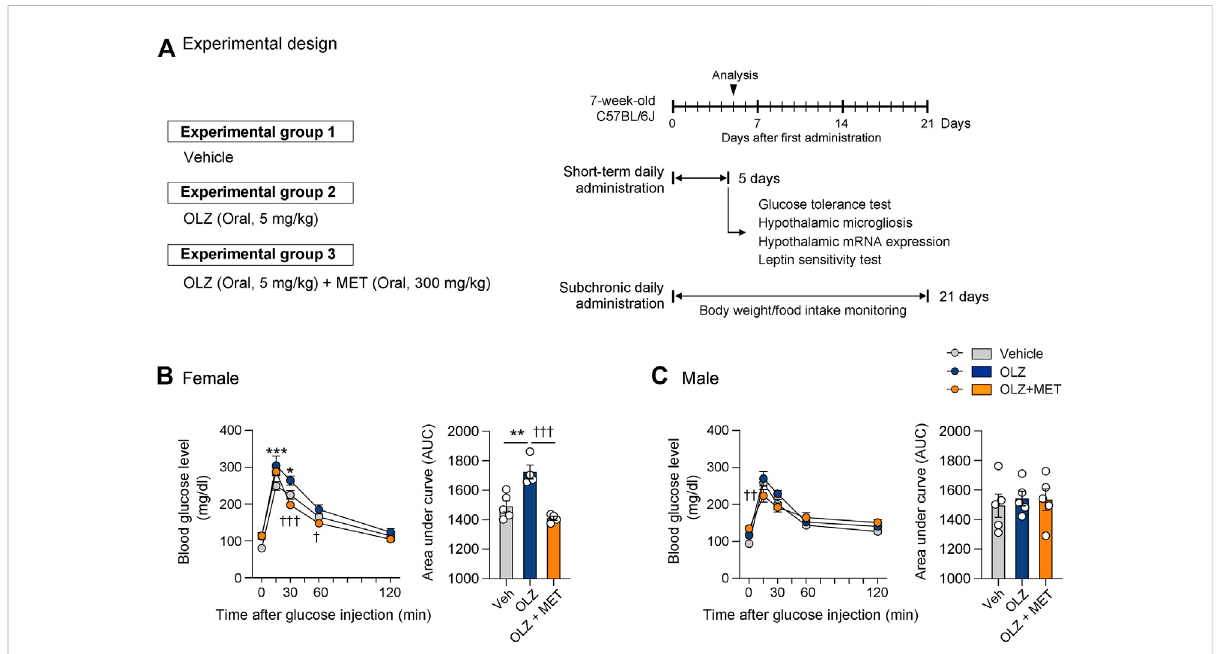
FIGURE 1 Metformin (MET) attenuates olanzapine (OLZ)-induced glucose intolerance in female mice. (A) Experimental scheme pertaining to mice that were administered OLZ or OLZ + MET on postnatal week 7. (B,C) Glucose tolerance tests were performed after the administration of OLZ or OLZ + MET for 5 days in female (B) and male mice (C) ( n = 4 – 5). Arrows indicate measurement time points. Data are presented as mean ± SEM values. Data were analyzed by one-sided one-way analysis of variance (ANOVA) followed by a post hoc least signi fi cant difference (LSD) test. * p < 0.05